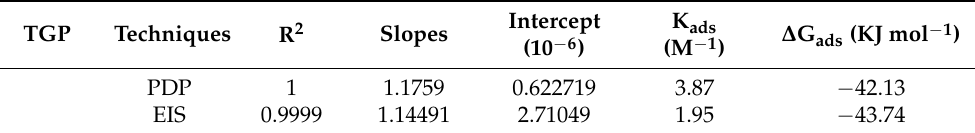
Figure 8. Langmuir adsorption isotherm model of TGP for MS in 1 M HCl medium using two techniques (PDP and EIS) at 298 K. Table 3. Adsorption and thermodynamic parameters for the corrosion of mild steel in the presence of the TGP at 303 k in acidic media.